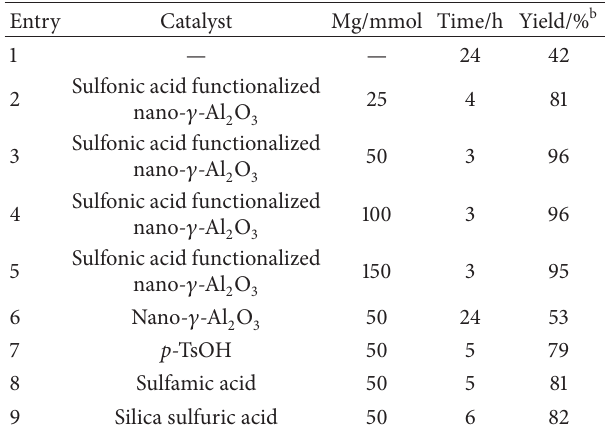
Table 1: Catalyst optimization for the synthesis of 3-phenyl-2 H -1,4- benzothiazine a